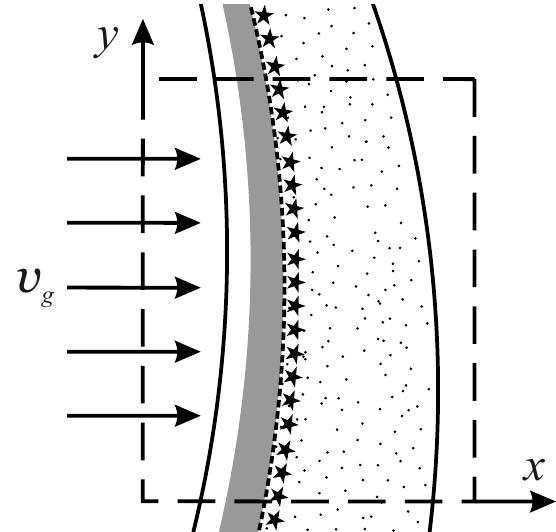
Figure 5. Schematic representation of a supersonic flow of gas flowing onto the spiral arm of the galaxy. The fragment of the arm, considered in the calculations, is marked with long dashed lines. In the first approximation, the curvature of the arm in the computational domain is neglected. The short-dashed line indicates the position of the front of the galactic shock wave. Stars markers and the shaded region along the front mark the location of the stellar dust source and a dust lane, respectively. Points show dust particles carried by the